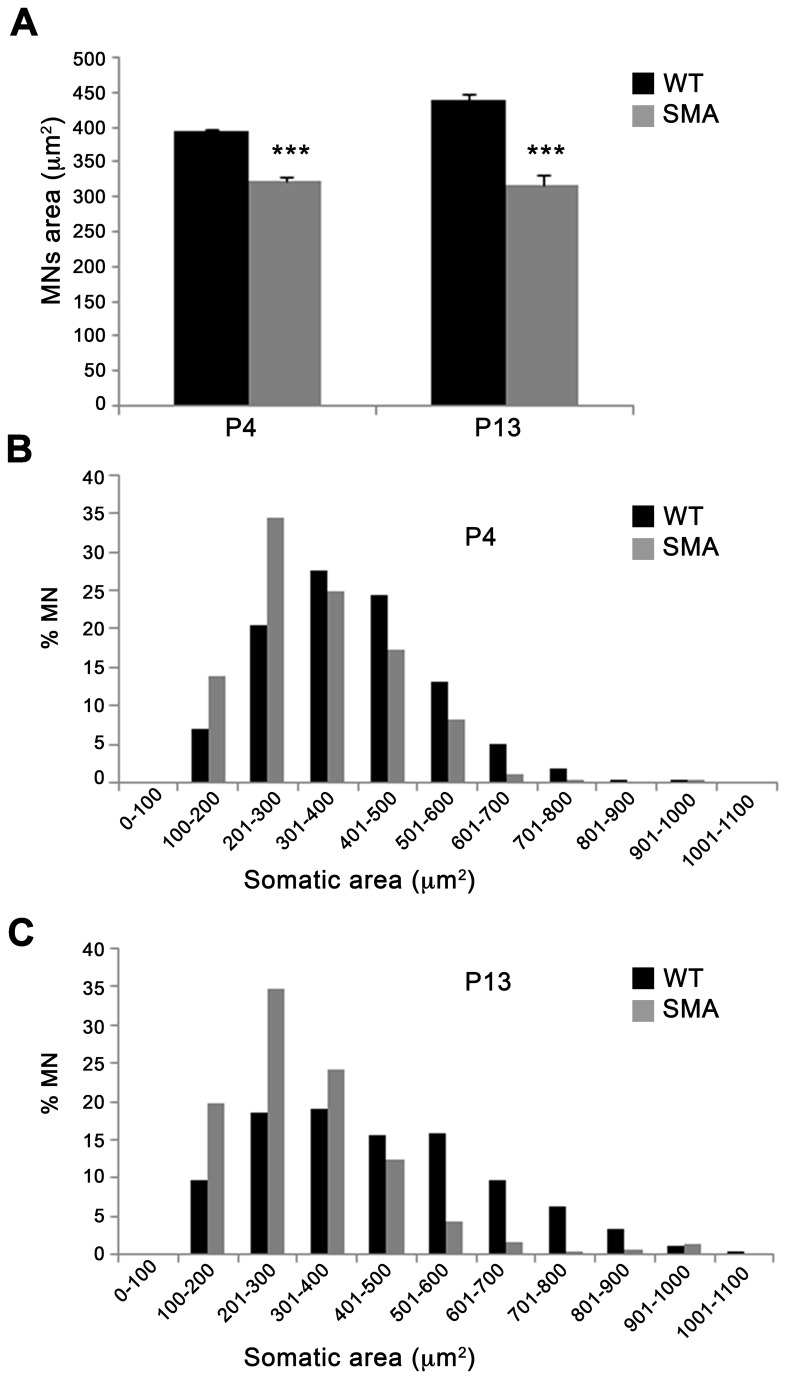
Large motor neurons are selectively affected in SMA.(A) Quantitative analysis at C3-C5 spinal levels revealed a significant reduction of mean motor neuron area in SMA vs WT mice at P4 (left) and P13 (right, ***p<0.001, t-test). (B, C) The analysis of the distribution of motor neuron areas (bins=100 µm2) revealed a significant shift to lower size in SMA vs WT mice at both P4 and P13 (***p<0.001, chi-square test between WT and SMA curves). Also note the reduction of motor neurons larger than 500 µm2 in SMA mice. Values are expressed as mean ± SEM.